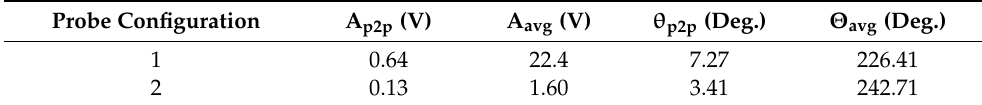
Table 4. Quantitative results of each ECT feature for the two excitation-probe configurations.